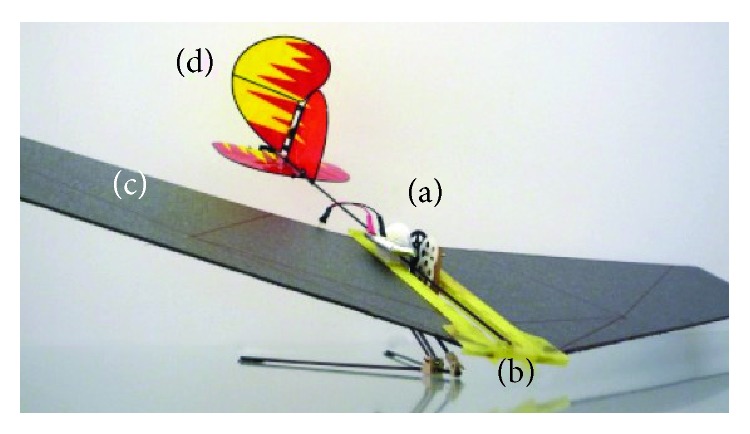
EPFL jumpglider [78].